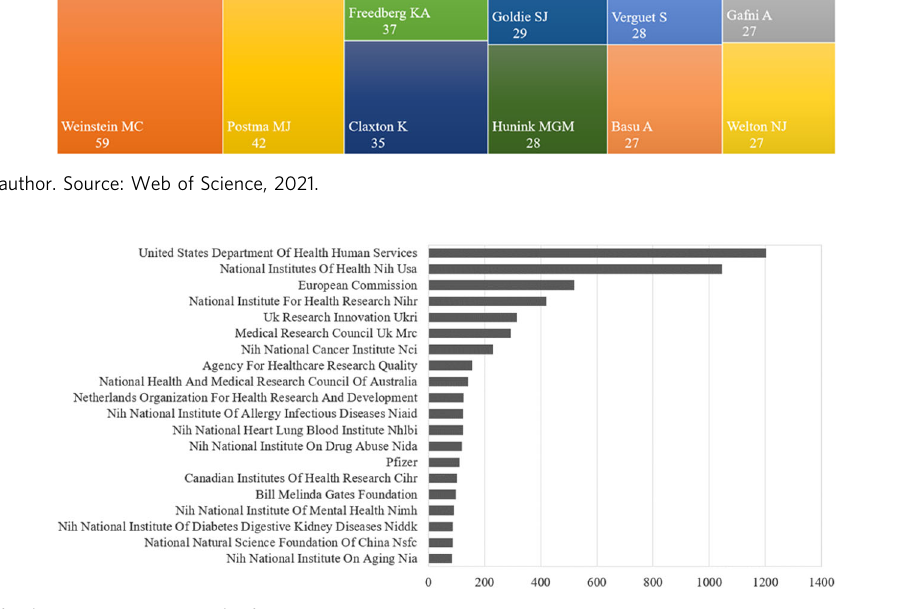
Fig. 6 Publications by funding entity. Source: Web of Science, 2021.